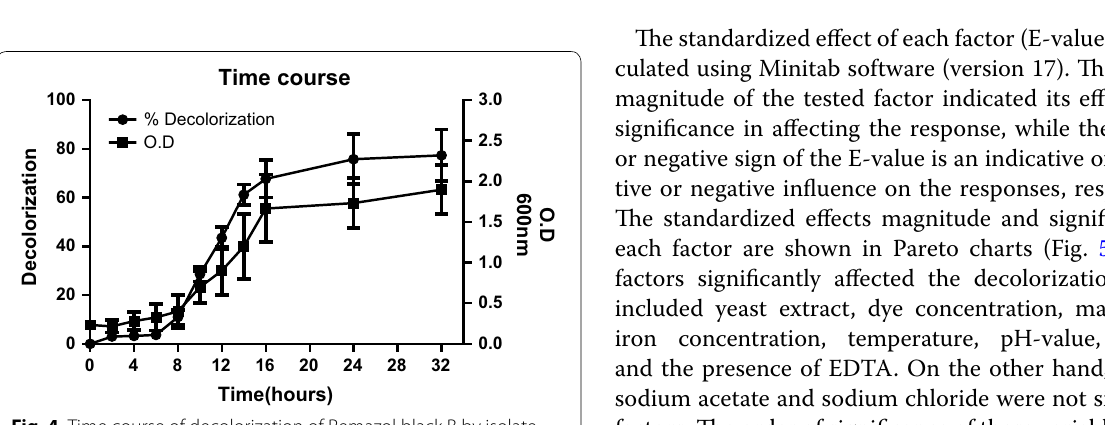
Fig. 4 Time course of decolorization of Remazol black B by isolate B1 (Pseudomonas aeruginosa ). Decolorization and O.D 600 of samples taken after 0, 2, 4, 6, 8, 16, 24 and 32 h were plotted against time. The data presented are the mean of 3 independent experiments and the error bars represent the standard deviation